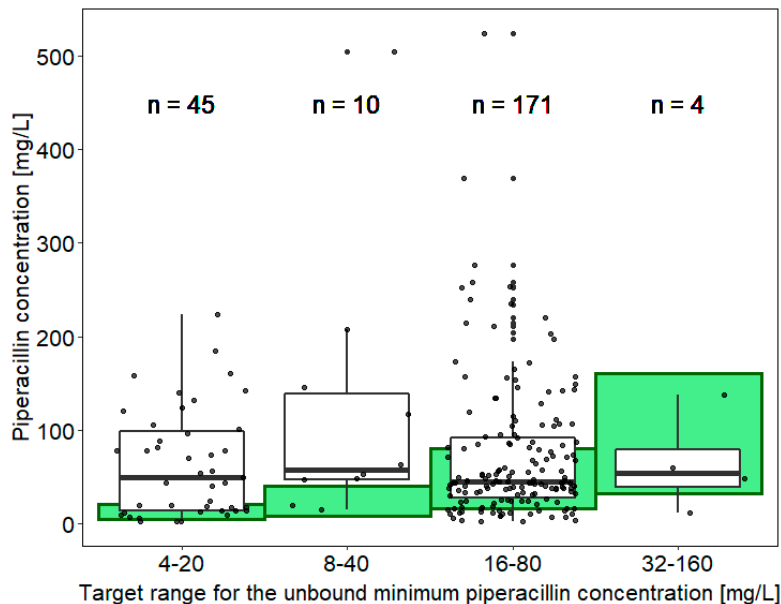
Figure A3. Boxplot of measured piperacillin concentrations stratified by targeted drug concentration range. Target range (Green shaded areas) for the minimum drug concentration defined as 1–5 × MIC. If no MIC values could be determined an empirical target of 16–80 mg/L was used. Unbound piperacillin concentrations were calculated based on the literature reported fraction unbound of 91% in critically ill patients [60]. Points : measured piperacillin concentrations .